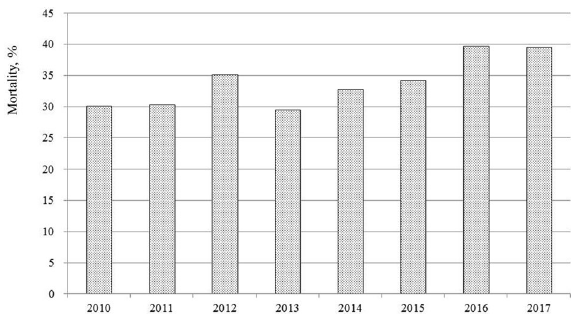
Figure 2. In-hospital mortality after dialysis among patients hospitalized between 2010 and 2017. All data are analyzed by the Cochran-Armitage Test for Trend (p = 0.2411) (Statistical Analysis System version 9.4; SAS Institute, Cary, NC, USA).